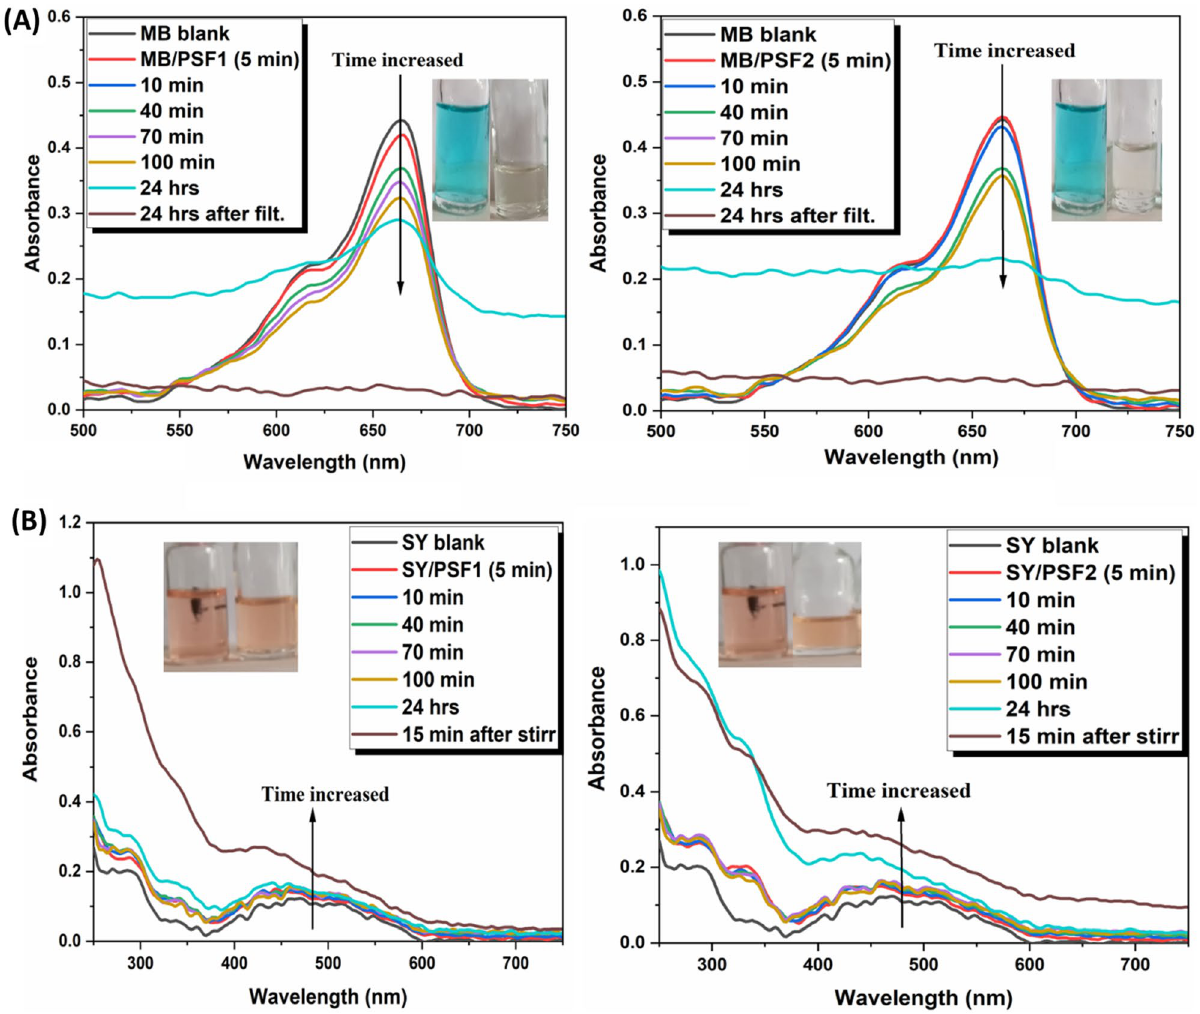
Figure 10. UV–Vis spectra of ( A ) single (MB) solution and ( B ) (SY) solution adsorption recorded at various times for PSF1 and PSF2, inset images are of solution left before and right after adsorption for each one.